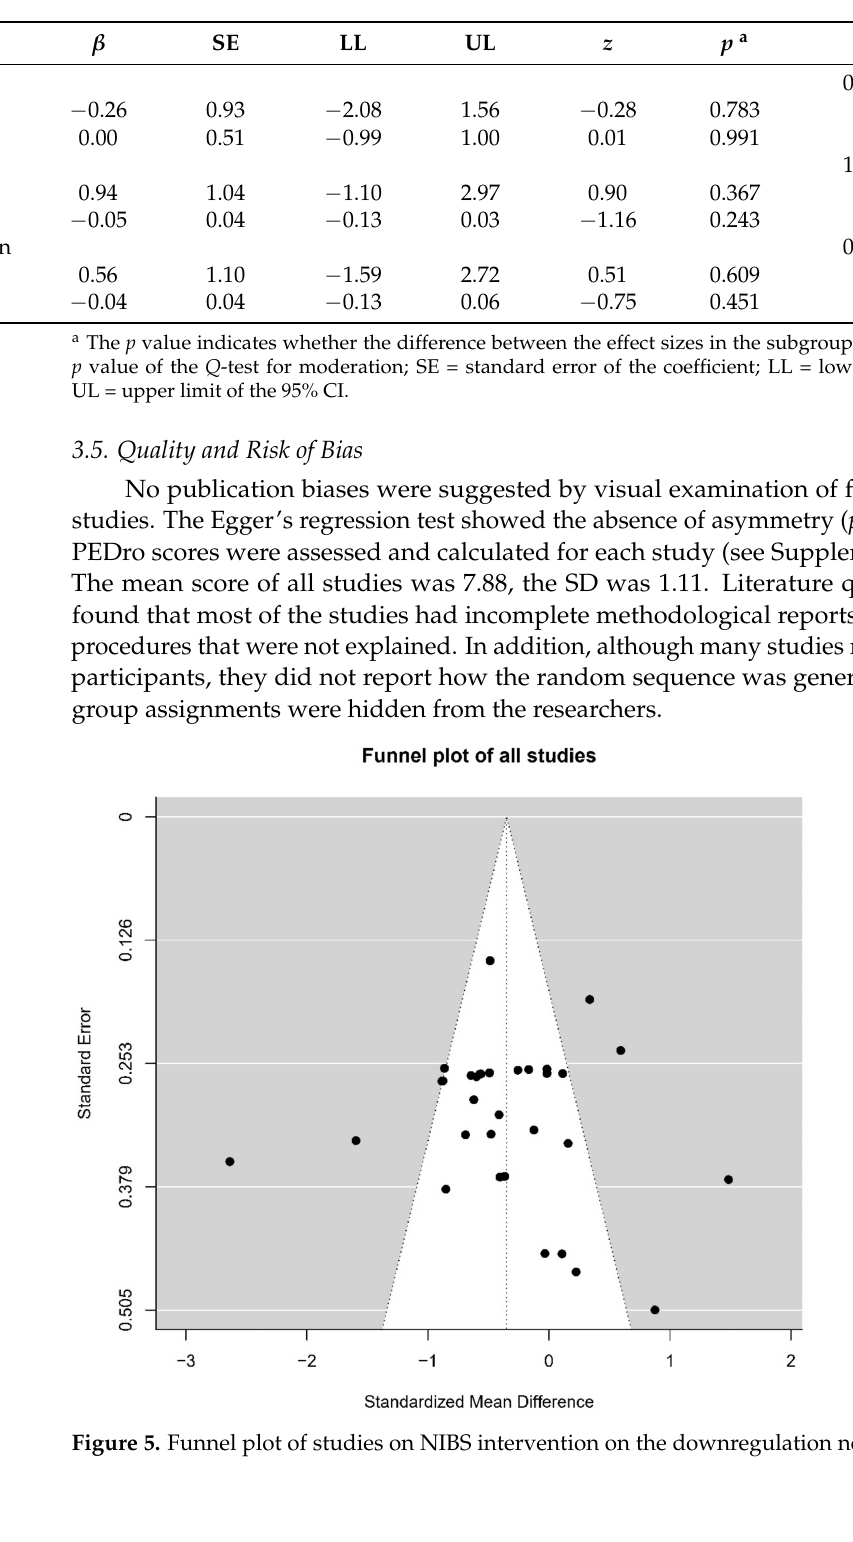
Table 4. Results of meta-regression analyses for continuous moderators.